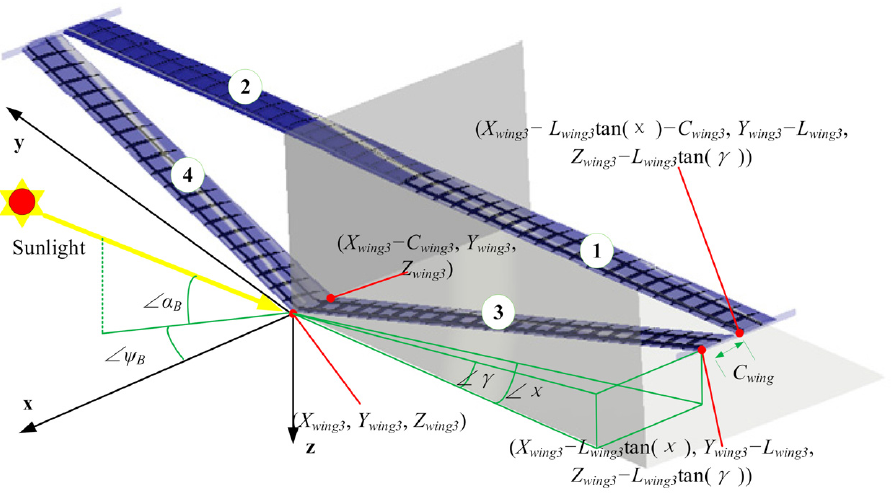
Figure 3. Wing sections and parameters of joint-wing layout. The shadow of the wing can be determined once the direction of solar irradiance is obtained from the solar irradiance model. The components of the direction are defined as X solar , Y solar and Z solar , and the point of the shadow ( X 0 , Y 0 , Z 0 ) should satisfy the line equation: